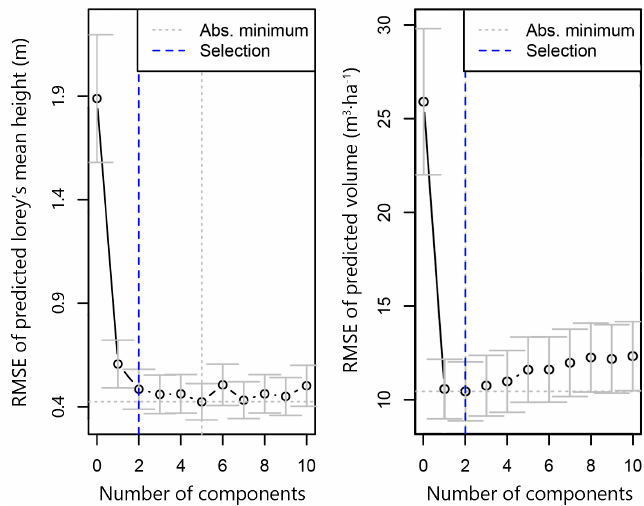
Figure A1. The selection of number of components using the approach based on the standard error of cross-validation residuals in the “pls” package within R environment software.